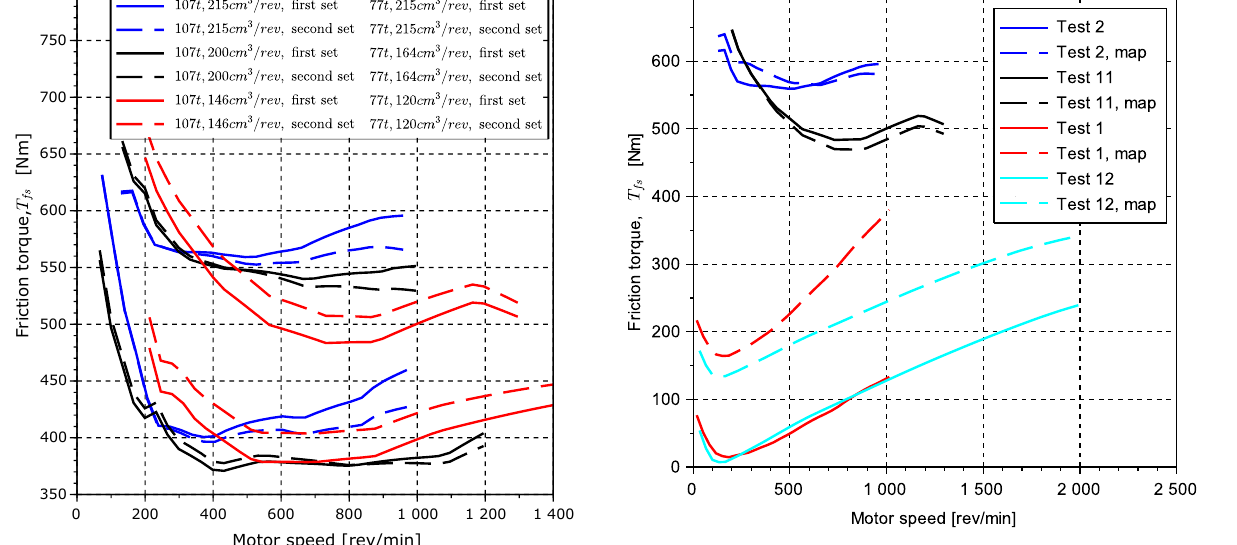
Figure 12: Calculated total system friction for tests with 77 and 107t load.